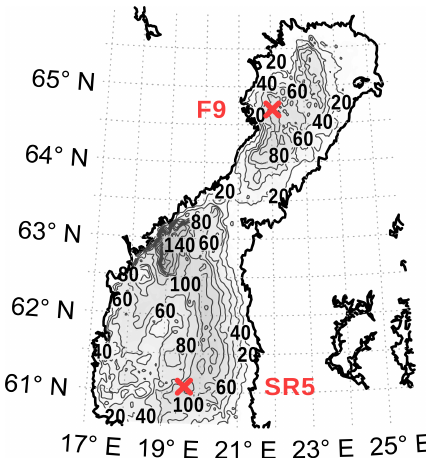
Figure A2. Location of the validation stations. The map was created using the software package GrADS 2.1.1.b0 (http://cola.gmu.edu/ grads/, last access: 19 June 2020), using published bathymetry data (Seifert et al., 2008).